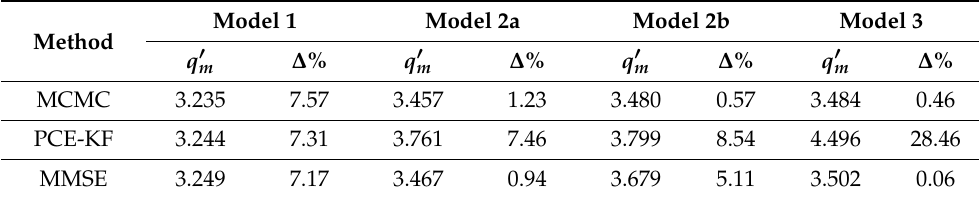
Table 3. Performance of the different updating procedures: comparison of posterior mode q (cid:48) m and q true = u + 3 σ = 3.5.